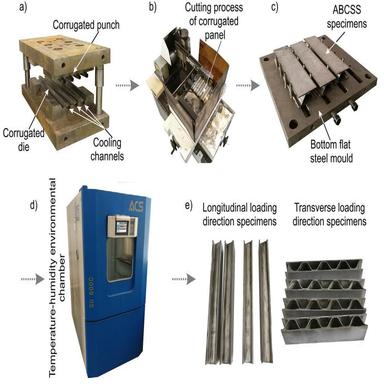
Manufacturing process of ABCSS specimen: a) Self-made in-house assembled stamping tool; b) Core panel cutting process; c) Bonding process of longitudinal specimens; d) Temperature-humidity environmental chamber; e) Ready-cured ABCSS specimens.